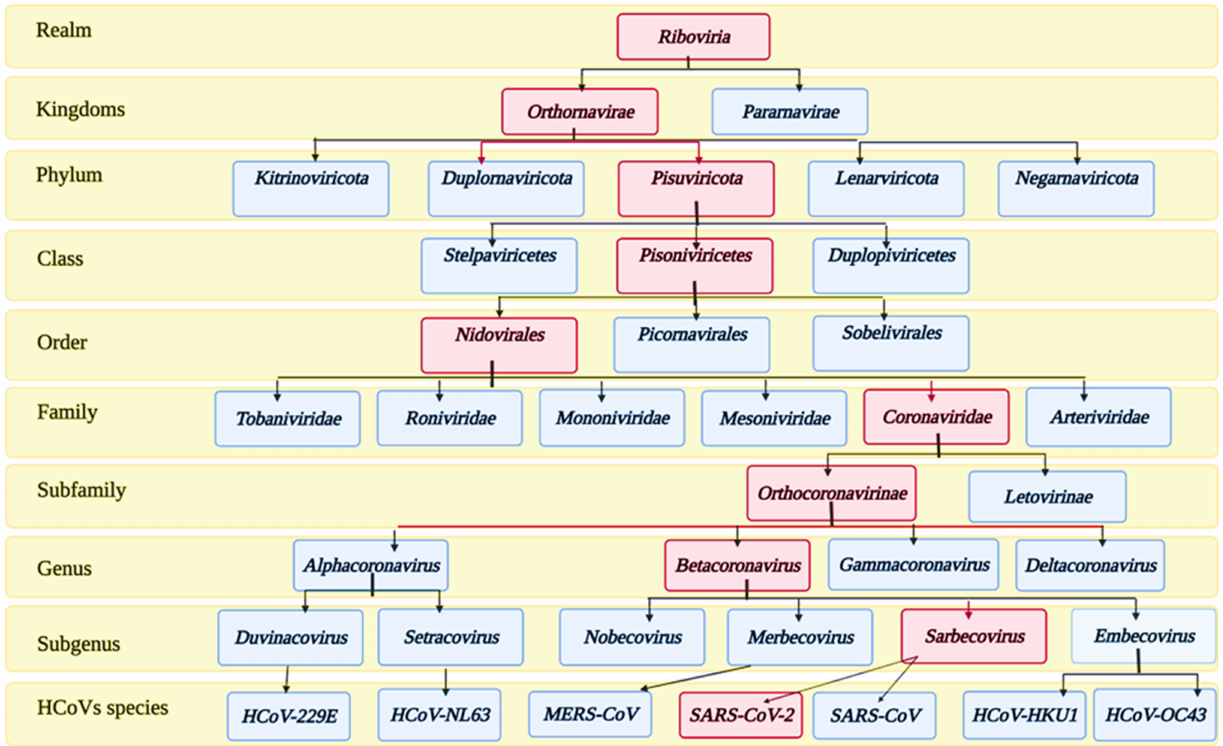
Figure 1. Taxonomy of human